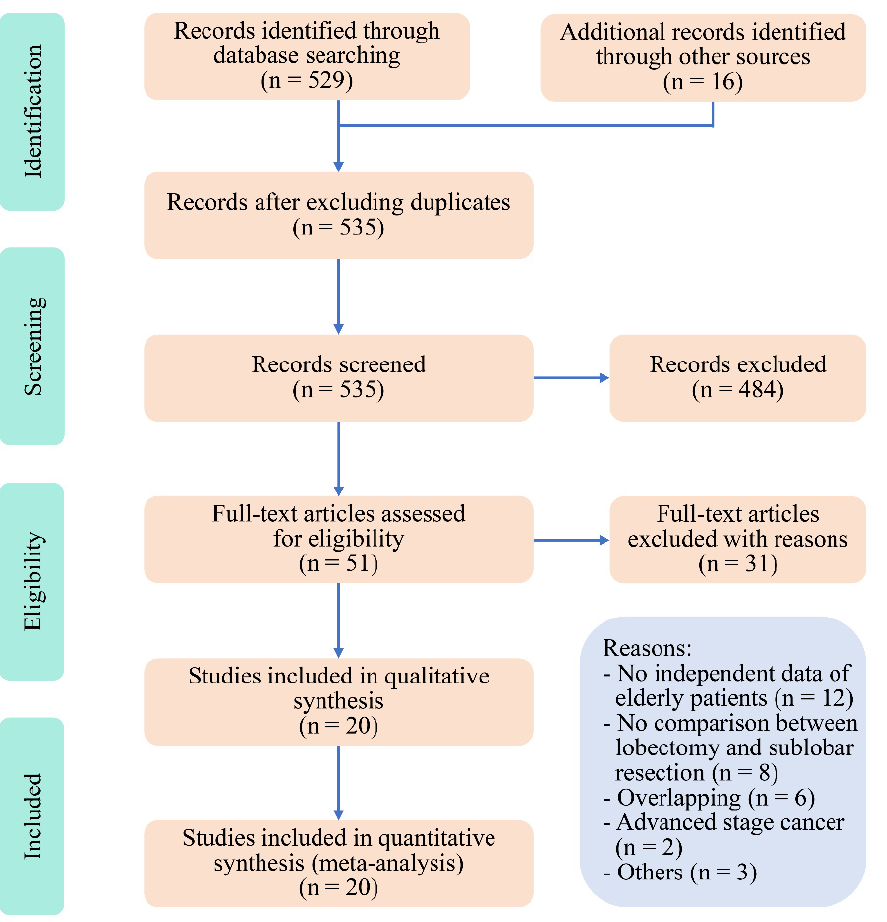
Figure 1. Preferred Reporting Items for Systematic Review and Meta-Analysis (PRISMA) flow diagram for study selection.